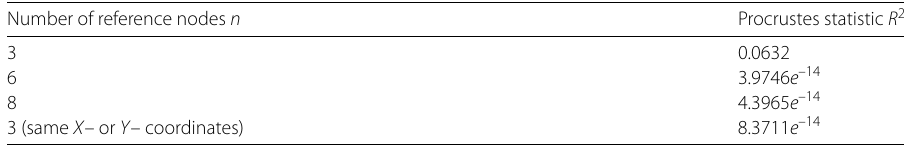
Table 3 Table of Procrustes analysis for the reference